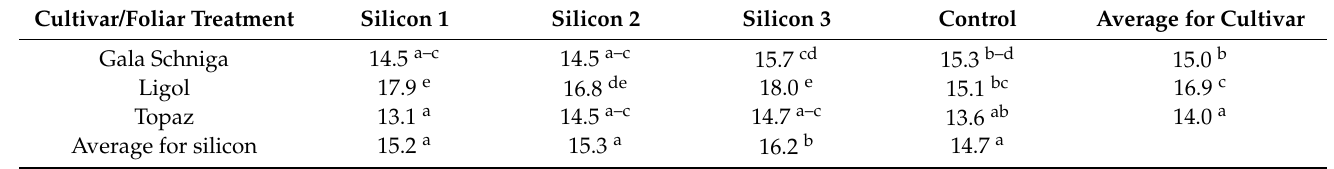
Table 4. The weight of 100 fruits of apple trees depends on cultivar and foliar silicon treatment